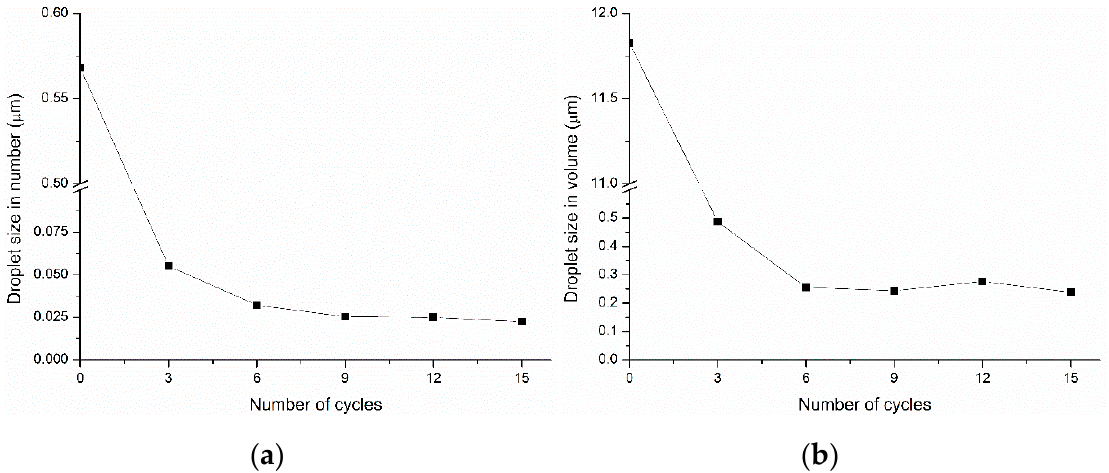
Figure 1. Influence of the number of cycles through high-pressure homogenization (HPH) on the particle size ( a ) in number and ( b ) in volume in a reference emulsion (O/W ratio of 20/80, 5 wt% saponin).